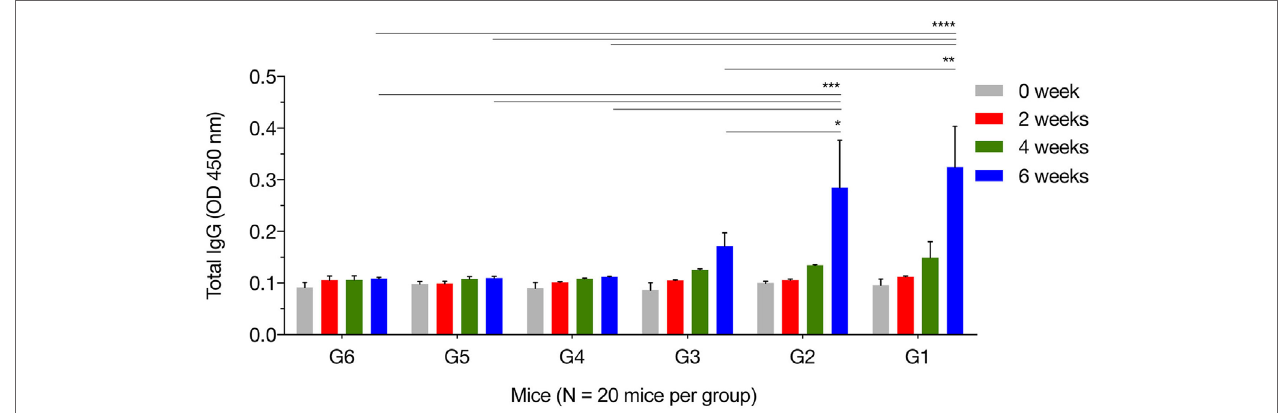
FigUre 1 | Antigen-specific antibody response in immunized mice. Total IgG antibodies were determined in the sera of mice pre-immunization (0 week) and at 2, 4, and 6 weeks post three consecutive booster immunizations. Experimental groups include G1 mice received pVAX1 plasmids containing five antigens (ROP16, ROP18, MIC6, CDPK3, and PF); G2 mice received pVAX1 plasmids containing four antigens (ROP16, ROP18, MIC6, and CDPK3); G3 mice received pVAX1-PF; G4 mice received an empty pVAX1; G5 mice received phosphate-buffered saline alone; G6 healthy control mice. Data are mean ± SDs for three wells (representative of three independent experiments). * p < 0.05, ** p < 0.01, *** p < 0.001, and **** p < 0.0001, compared with the control